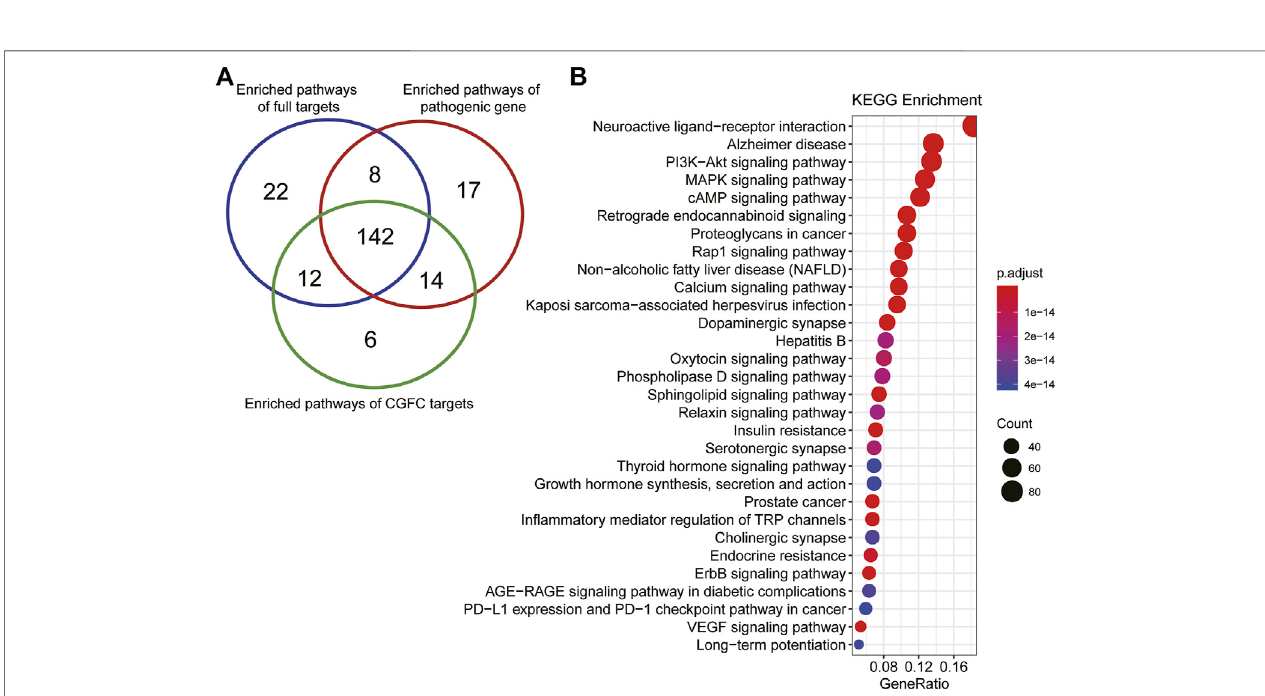
FIGURE 6 | Pathway enrichment analysis of the targets of CGFC. (A) . Venn diagram shows the coincidence of enrichment pathways of full targets, pathogenic genes, and CGFC targets. (B) . The top 30 enriched pathways of CGFC targets, the size of the circle represents the number of genes enriched in the pathways, and the color change of the circle represents the signi fi cance of the enrichment of genes in the pathways.